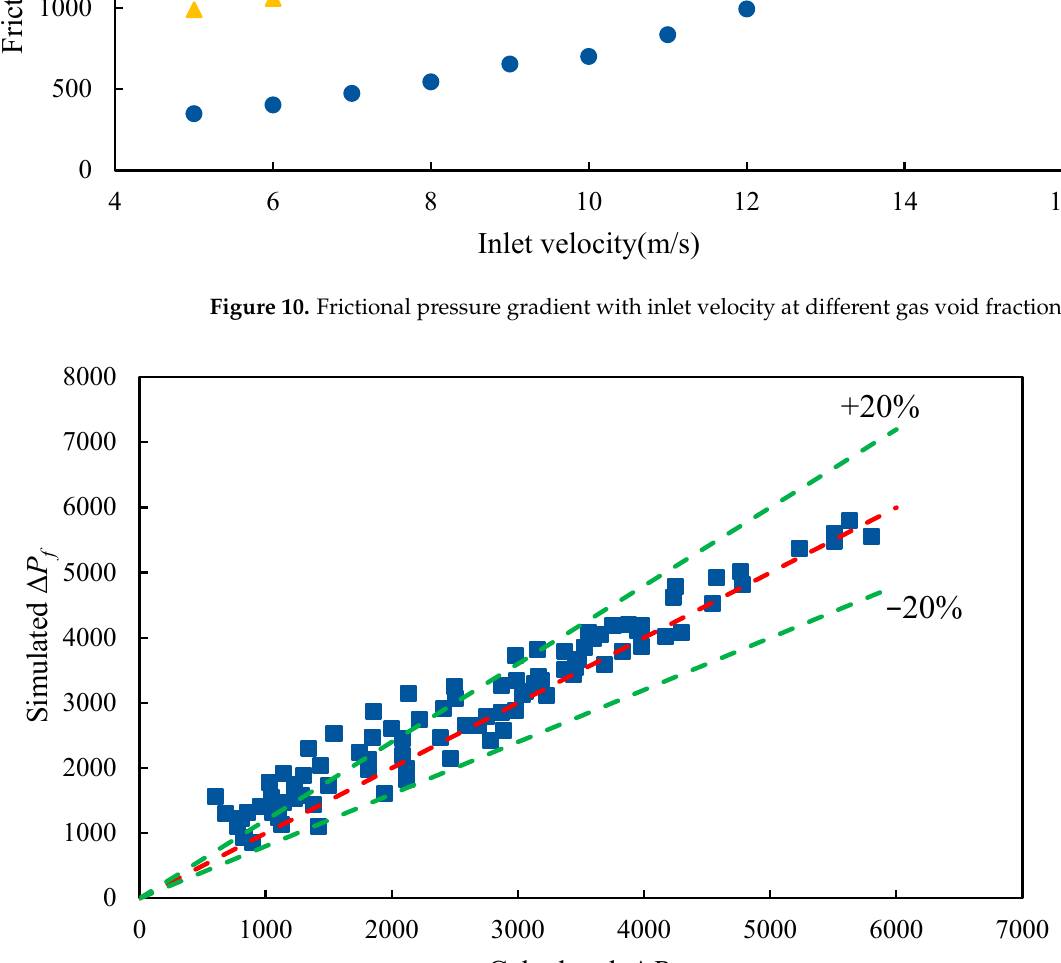
Figure 11. Comparison of calculated frictional pressure with simulated data.